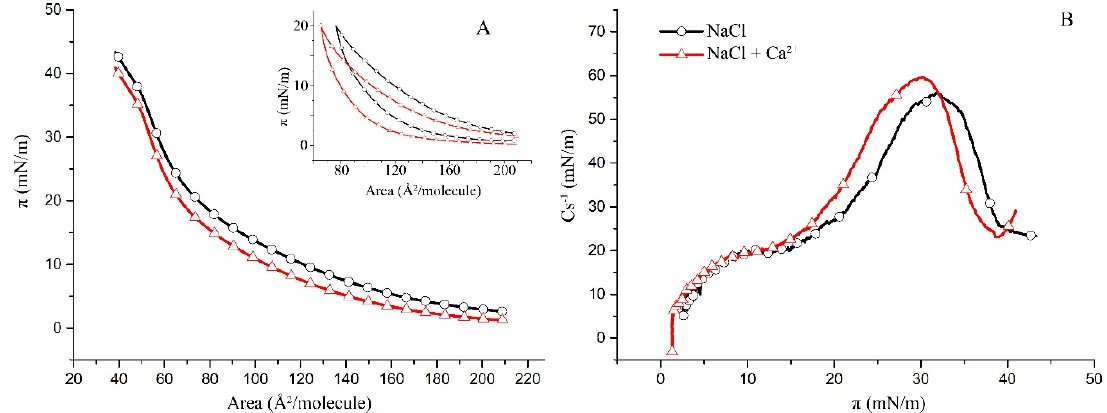
Figure 4. ( A ) Surface pressure/mean molecular area isotherms of the ternary hBest1/POPC/Chol (1:45:45) monolayers in a subphase of 150 mM NaCl (black) and in 150 mM NaCl supplemented with 0.5 µM CaCl 2 (red) at 35 ± 2 °C (inset: π /A hysteresis cycles of compression–decompression); ( B )